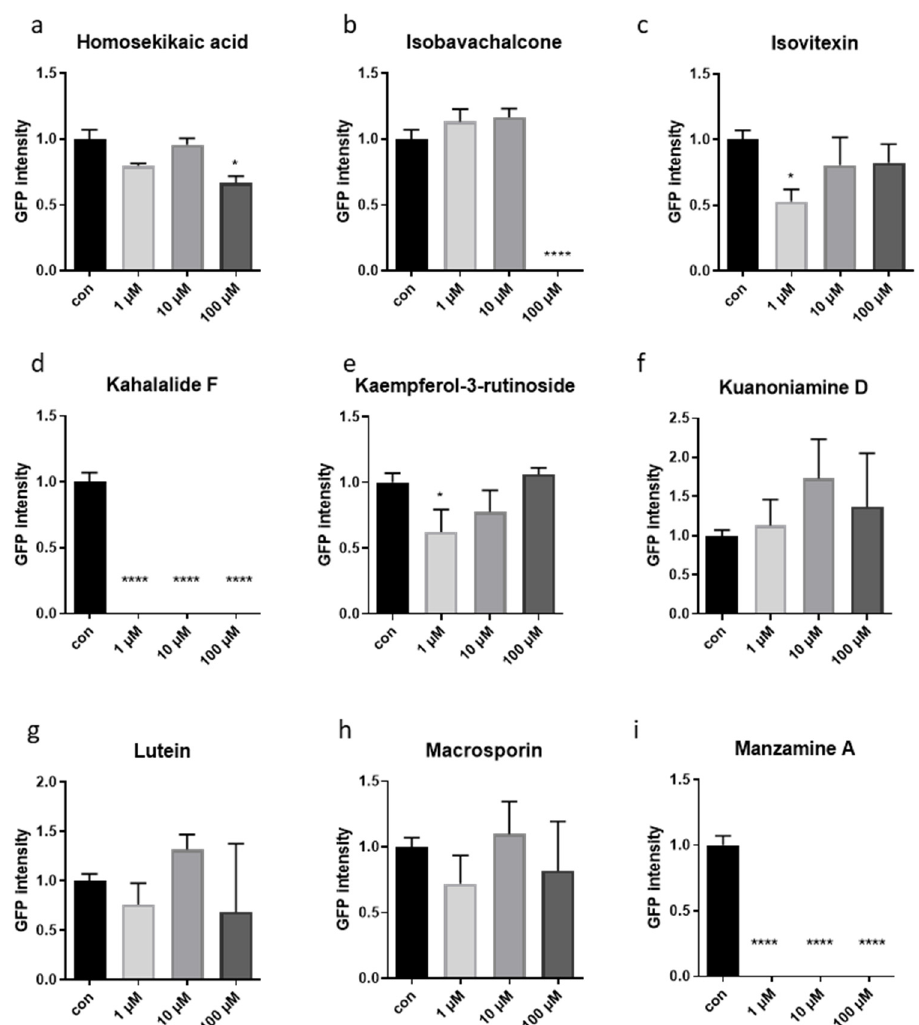
Figure 2. GFP expression in gst-4 ::GFP reporter strain measured with the Cellomic ArrayScan in liquid culture. ( a – i ) GFP intensity was measured with the Cellomic ArrayScan in liquid culture. Worms were treated either with DMSO (1%) (con) or with one of the 9 selected compounds of marine origin, at three different concentrations. The animals were treated for 3 days (from L1 stage). Measurements are indicated as mean ± SEM. One-way ANOVA. In all panels, asterisks (*) denote statistical significance: * p value ≤ 0.05, **** p value ≤ 0.0001 compared with control.